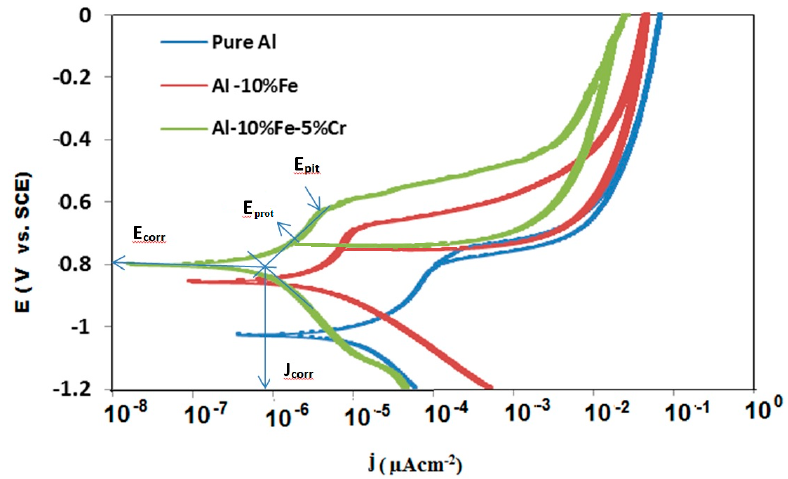
Figure 4. Potentiodynamic polarization curves for pure Al, Al-10% Fe and Al-10% Fe-5% Cr alloy immersed in 3.5% NaCl after 1 h at room temperature. Table 1. Potentiodynamic polarization parameters of pure Al, Al ‐ 10% Fe and Al ‐ 10% Fe ‐ 5%Cr alloy in 3.5% NaCl at room temperature after 1 h immersion time.